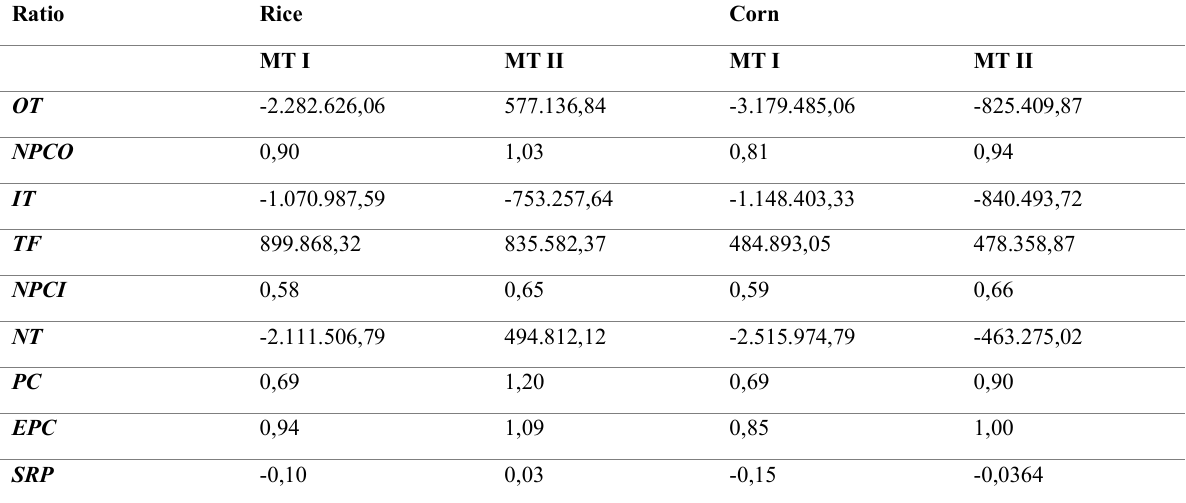
Table 6 : Indicators of government policy on strategic food commodities farming in